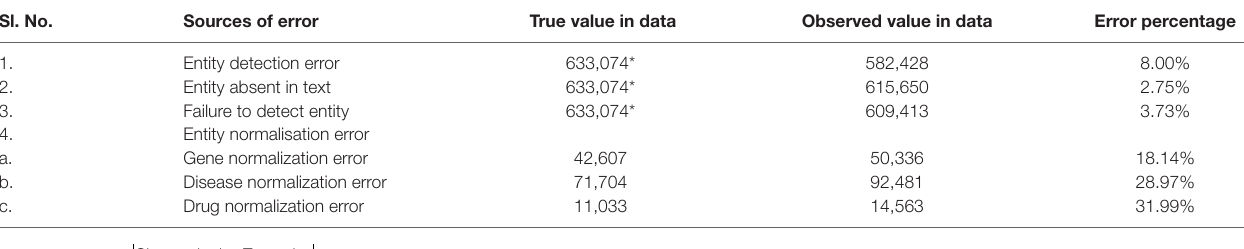
TABLE 2 | Error analysis evaluation results on different types of error occurrence on the test dataset. Sl.